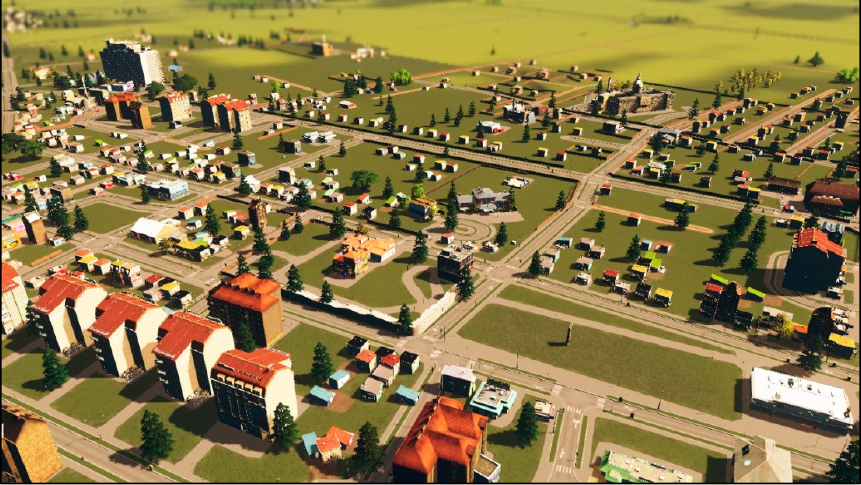
Figure 8. The urban area of the ˙Zuromin commune. Table 1. Import and integration of geodata in the game engine Cities: Skylines